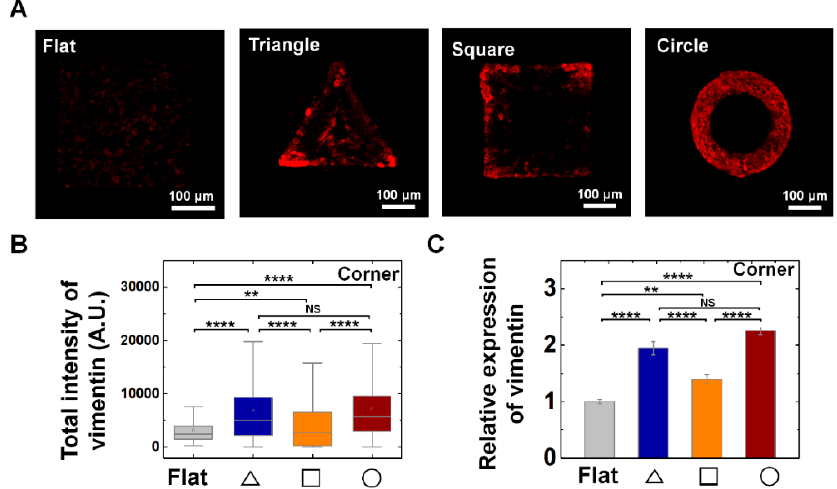
Figure 4. Enhanced vimentin expression on convex geometric structure. ( A ) Representative fluorescence images of vimentin (red) in MDCK cells on the flat and triangle, square, circle structure. ( B ) The box plots indicate the total intensity of vimentin per individual cells on corner of triangle (navy), square (orange) and circle (red) structure. The result from flat surface is plotted in gray color as a control ( N = 3). ( C ) Mean relative vimentin intensity of the cells on the geometric structure compared to that on the flat surface. N cell for flat surface and triangle, square, circle structure was 457 and 306, 473, 919, respectively ( N = 3). Error bars in graph indicate S.E.M. One-way ANOVA test with post-hoc Fisher’s LSD was used. **** p < 0.0001; ** p < 0.01; NS, not significant.